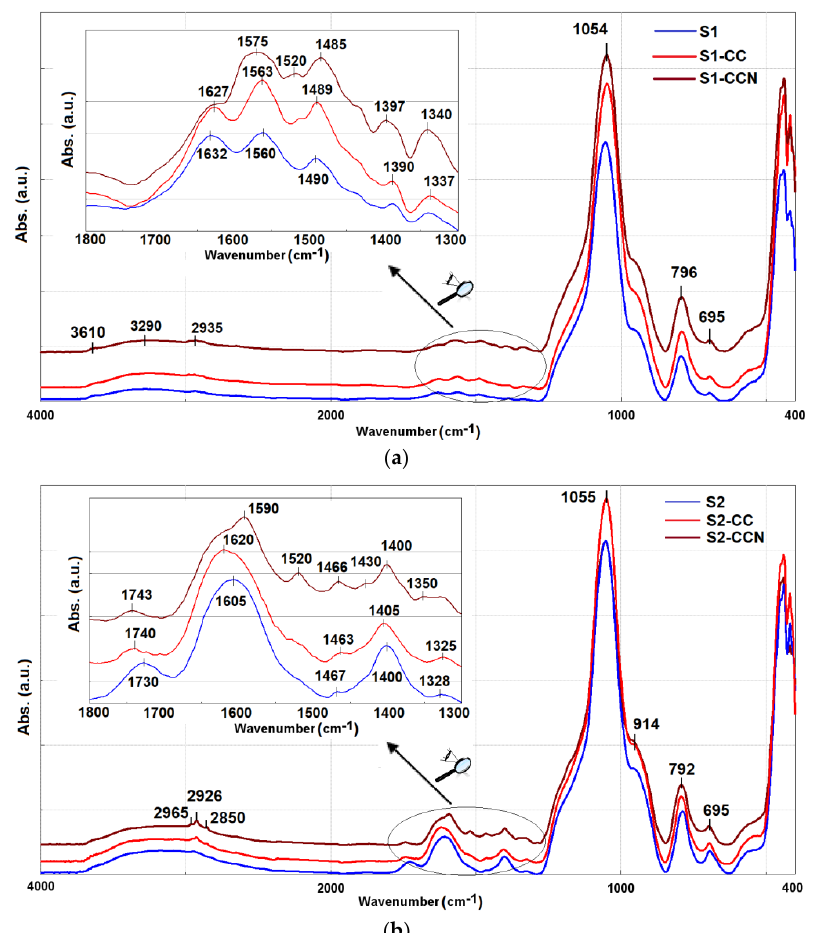
Figure 6. FTIR spectra of the hybrid materials modified with aminopropyl groups ( a ) and glycine residue ( b ). residue ( b